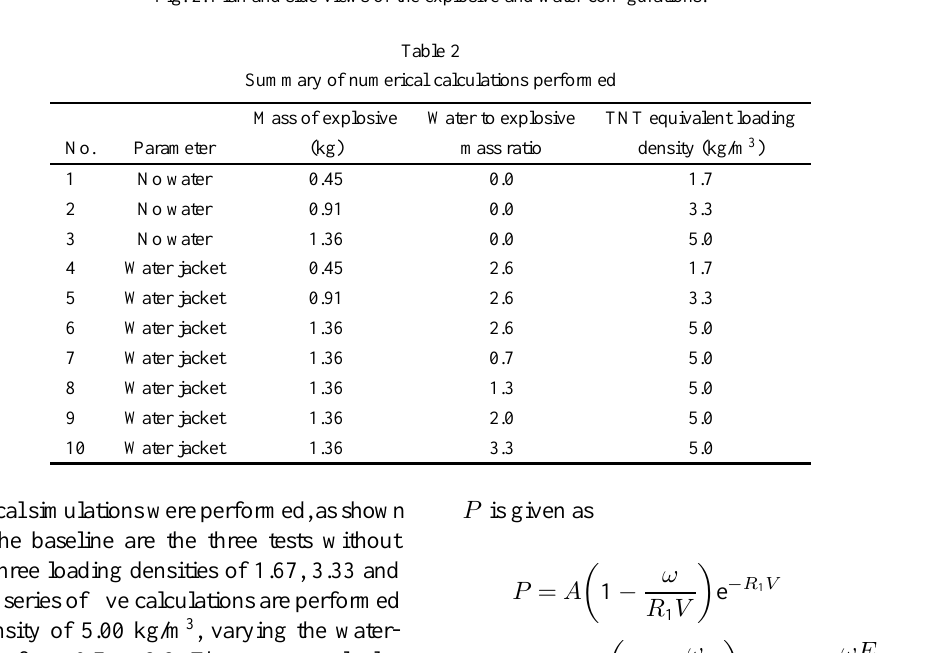
Fig. 2. Plan and side views of the explosive and water configurations.